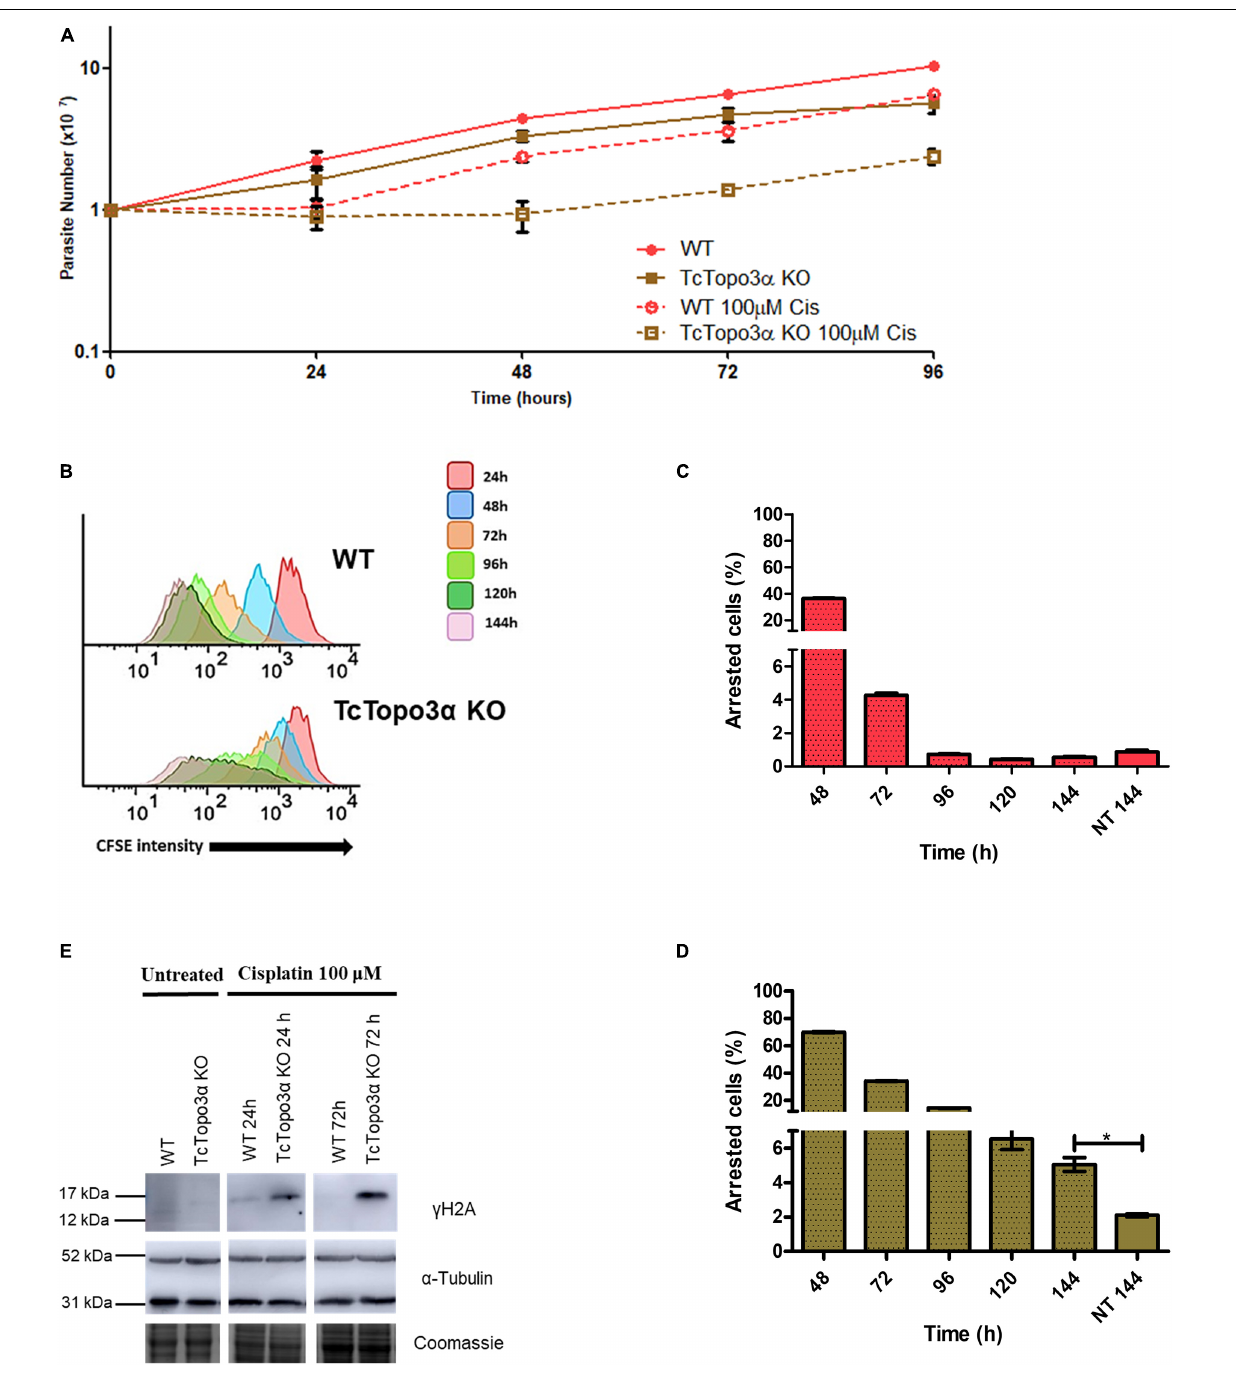
Frontiers in Cell and Developmental Biology |